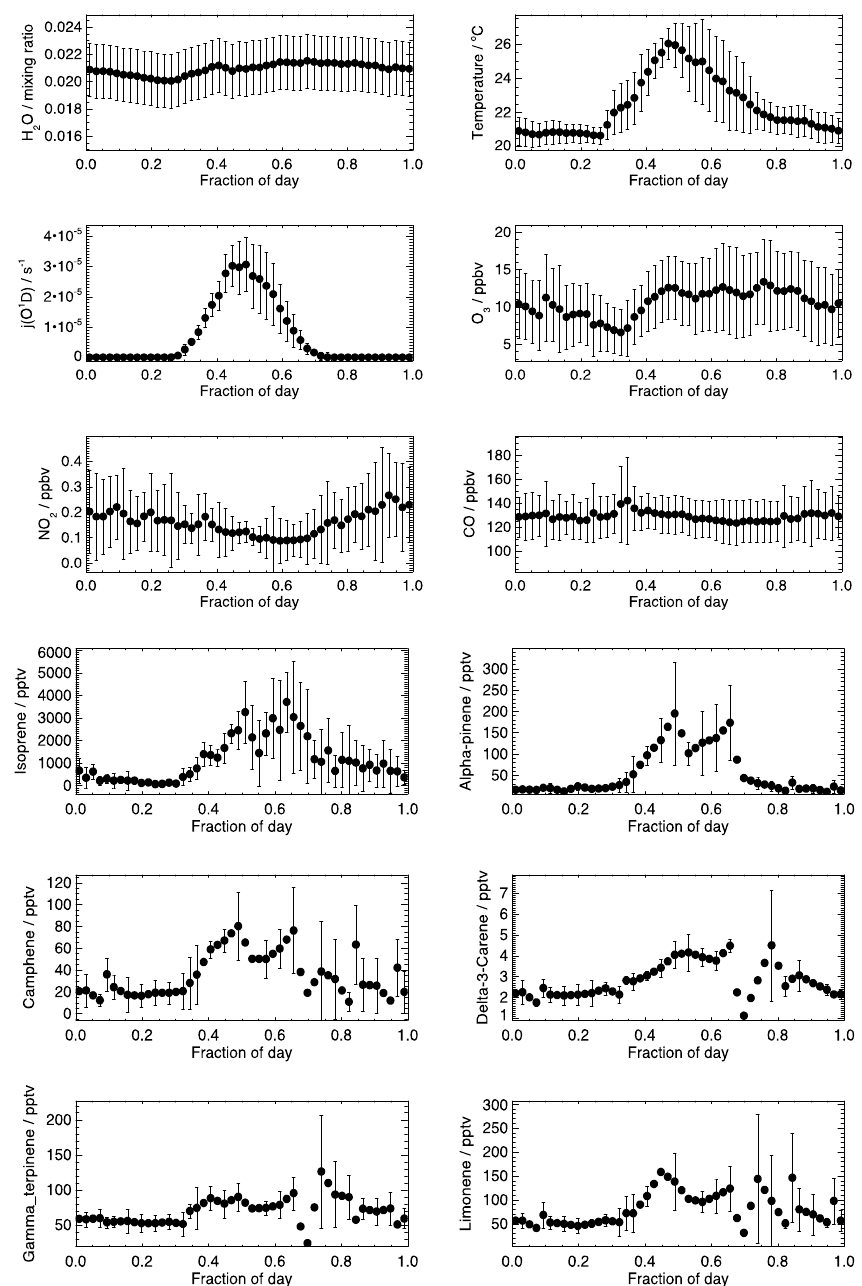
Fig. 1. Average diurnal cycles (local time) of measured species used to constrain the model, averaged into 30min time bins, with error bars indicating the 1 σ variability on the observations. All average values are means, except for NO 2 where the median has been used due to large spikes in the data. For hydrocarbons where the sampling period was less than every 30min, the data were interpolated between their measurement